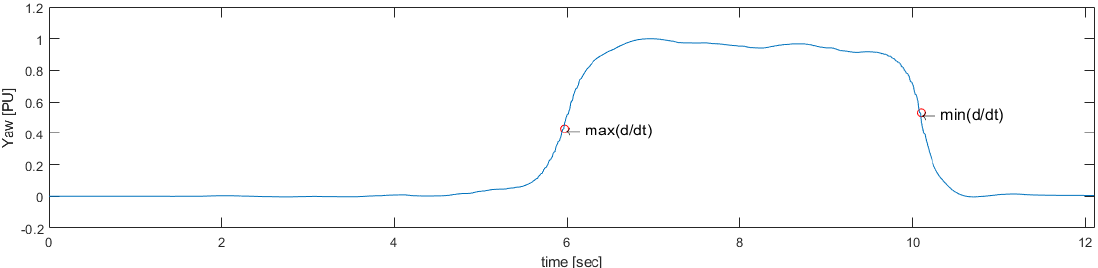
Figure 9. Maximum and minimum of the rotation signal derived to start the search for turning